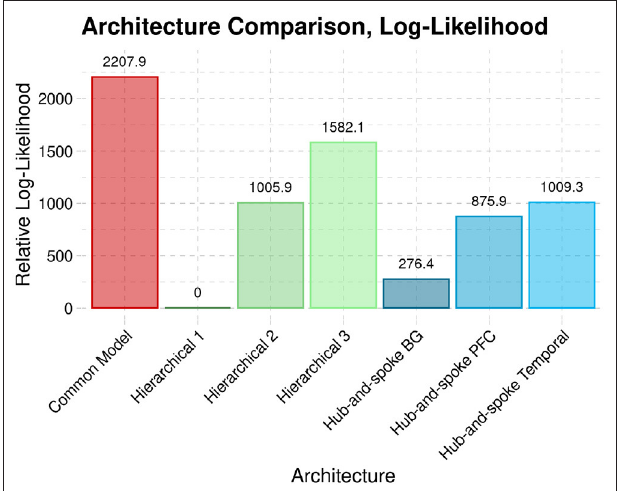
FIGURE 8 | Probability densities that each architecture would best fit the data from a participant in our sample. Numeric labels represent the exceedance probabilities associated with each distribution.